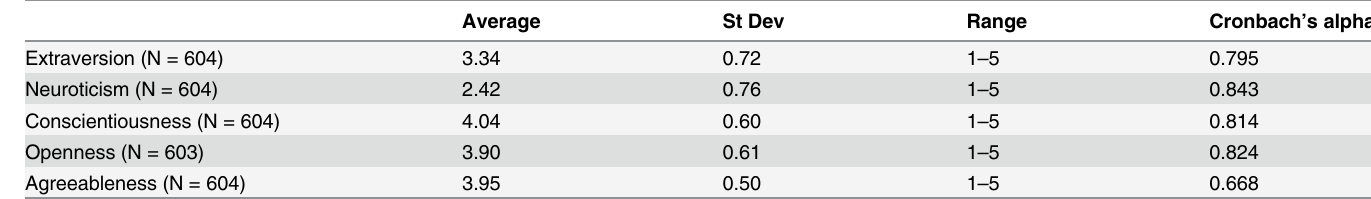
Table 2. Big Five